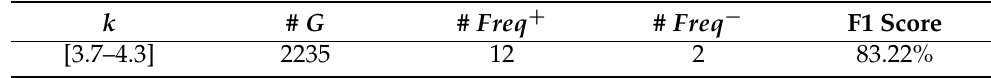
Table 11. Term distribution of [3.7–4.3] k for MARSA (Social) using SVM.